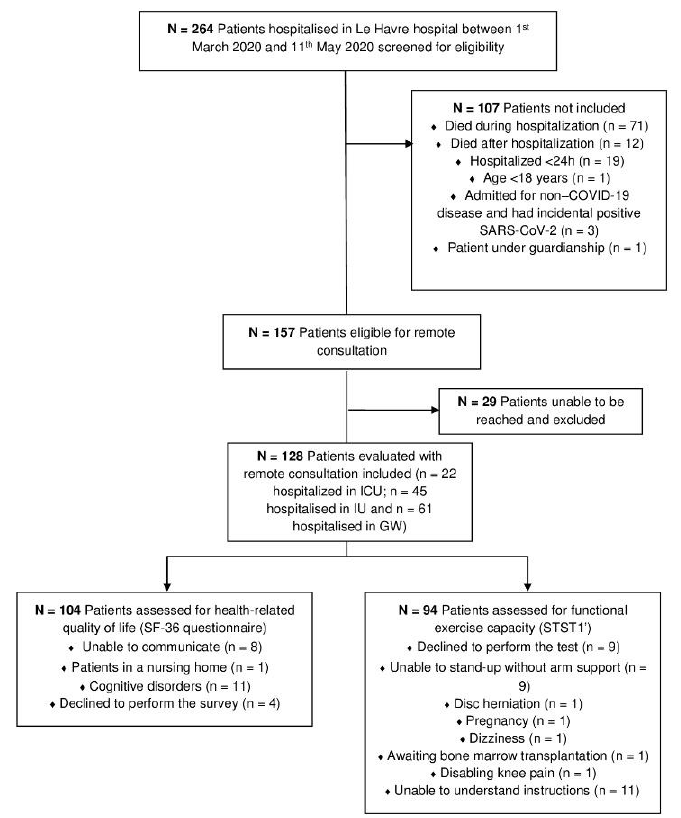
Figure 1. Flow diagram of patients screening and